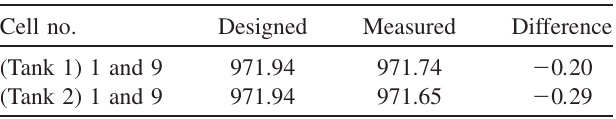
TABLE X. End-cell frequencies vs designed frequency (unit: MHz). Cell